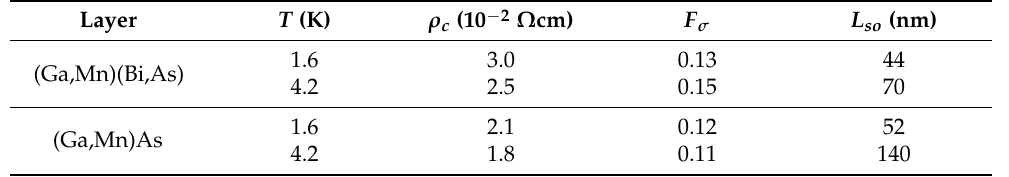
Figure 7. Longitudinal resistivity vs. perpendicular magnetic field measured for the Hall bars of (Ga,Mn)(Bi,As) and (Ga,Mn)As layers at temperatures of 1.6 K and 4.2 K (open circles), compared with fitting curves (red lines) within the weak localization theory for the 2D ferromagnet (see text for details). The visible set of experimental points, that are chosen to fit, is limited to the | B ⊥ | > 0.4 T range. The results are shown in the absolute resistivity scale ( a ) and their changes with respect to their values at the maximum field, Δρ xx , (vertically offset for clarity) ( b ) to compare the changes. Table 1 summarizes the obtained fitting parameters. The presented results show that the fitted values of ρ c are lower than the corresponding experimental ρ xx ( B = 0) ones that are due to the quantum correction Δσ xx at the B = 0 limit, which takes the non-zero nega- Table 1. The best fit values of fitting parameters: ρ c , F σ , and L so , corresponding to the fitted curves in tive value. Note that both, Δσ xx and ρ c , are related to each other by the momentum relax- ation time τ p . The obtained ρ c values correctly reproduce the increase of ρ xx ( B = 0) with Figure 7. decreasing temperature and their larger values for the Bi-contained layer. On the other hand, the fitted spin–orbit scattering length, L so , reveals distinctly lower values for the Bi-contained layer, as seen in Table 1, in agreement with the enhanced SOC strength.